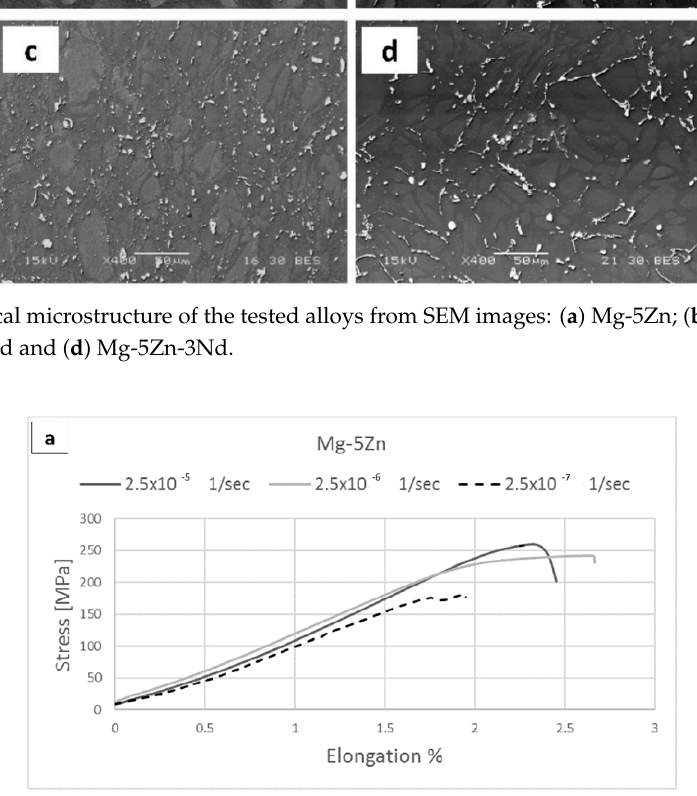
Figure 1. Typical microstructure of the tested alloys from SEM images: ( a ) Mg-5Zn; ( b ) Mg-5Zn-1Nd; ( c ) Mg-5Zn-2Nd and ( d ) Mg-5Zn-3Nd.